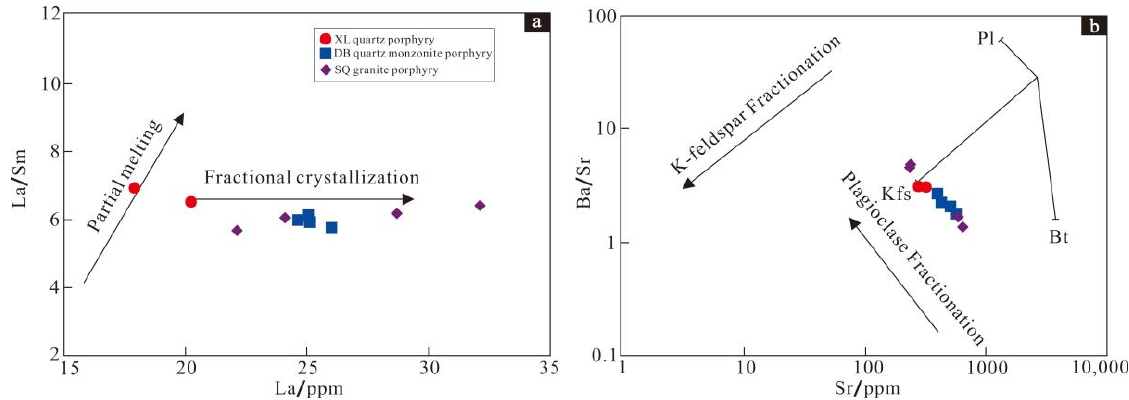
Figure 11. Diagrams of ( a ) La versus La/Sm; ( b ) Sr versus Ba/Sr. Pl- plagioclase; Kfs- K-feldspar; Bt-biotite.